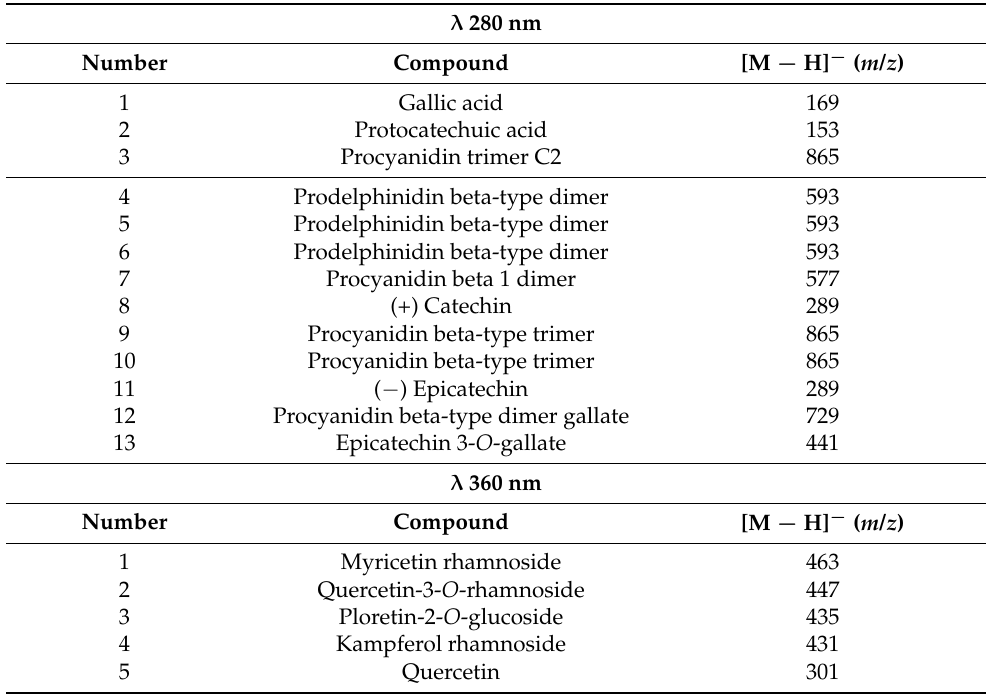
Table 4. Chromatographic data regarding the phenolic compounds identified in hazelnut skin extract by HPLC-PDA/ESI-MS (280 nm and 360